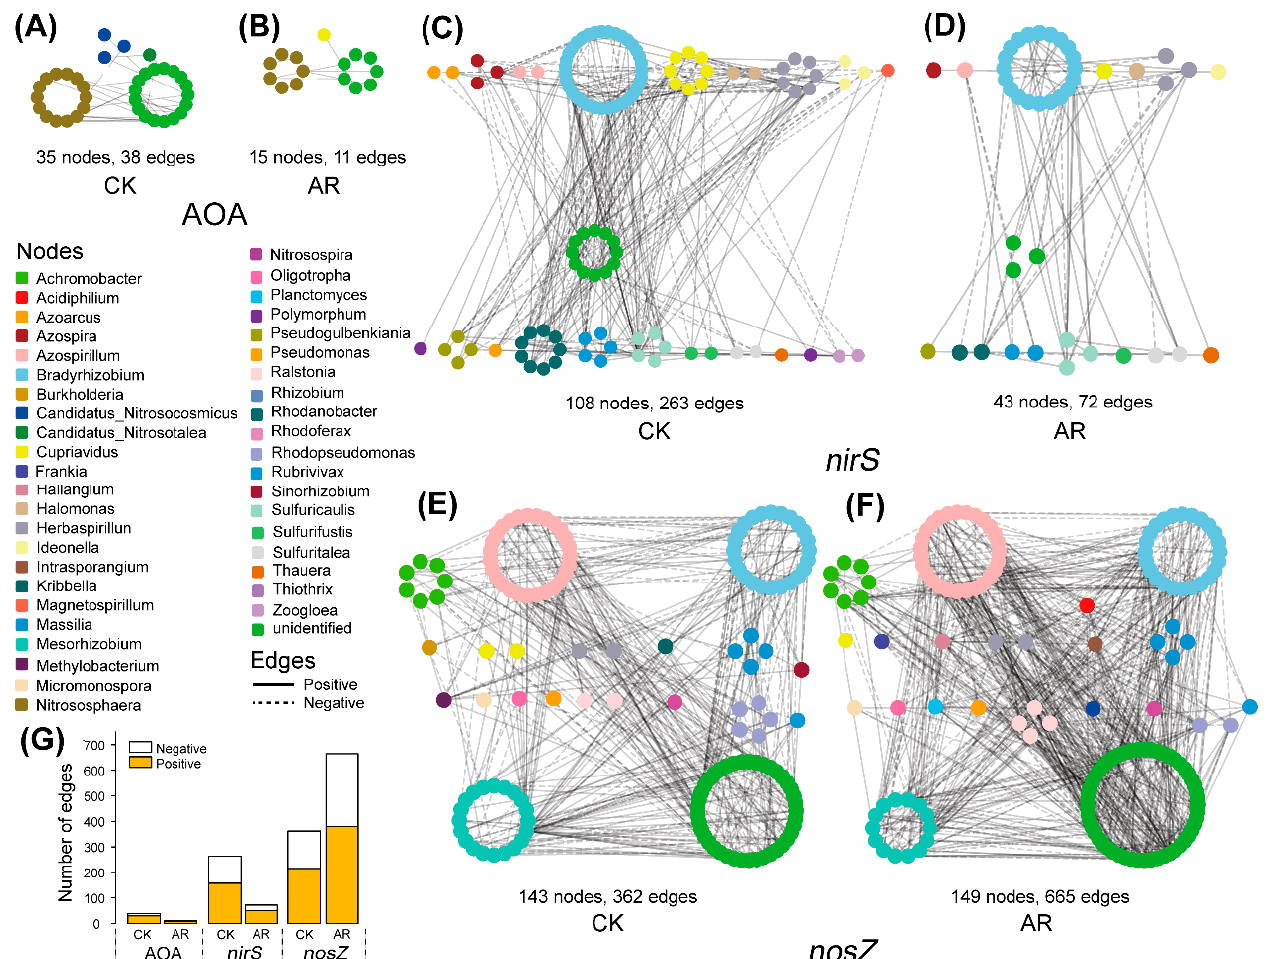
. Figure 1. Co-occurrence networks of the microbial communities in control (CK) and acid rain (AR) treatments. Nodes represent different OTUs, and OTUs are colored by genus-level taxonomy. Edges indicate the significant ( p < 0.05) relationships among different OTUs. AOA: ammonia-oxidizing archaea ( A , B ); nirS and nosZ : denitrifiers carrying nirS and nosZ genes, respectively ( C – F ). Number of edges ( G ). CK: non-acid addition, AR: pH 4.0 acid rain. Table 1. Key topological indices of microbial networks of ammonia-oxidizing archaea (AOA), nirS -, and nosZ -carrying denitrifiers. Microbial Topological Features Community Clustering Network Shortest Avg. Number of Graph Treatment Nodes a Edges b Coefficient c Diameter d Paths e Neighbors f